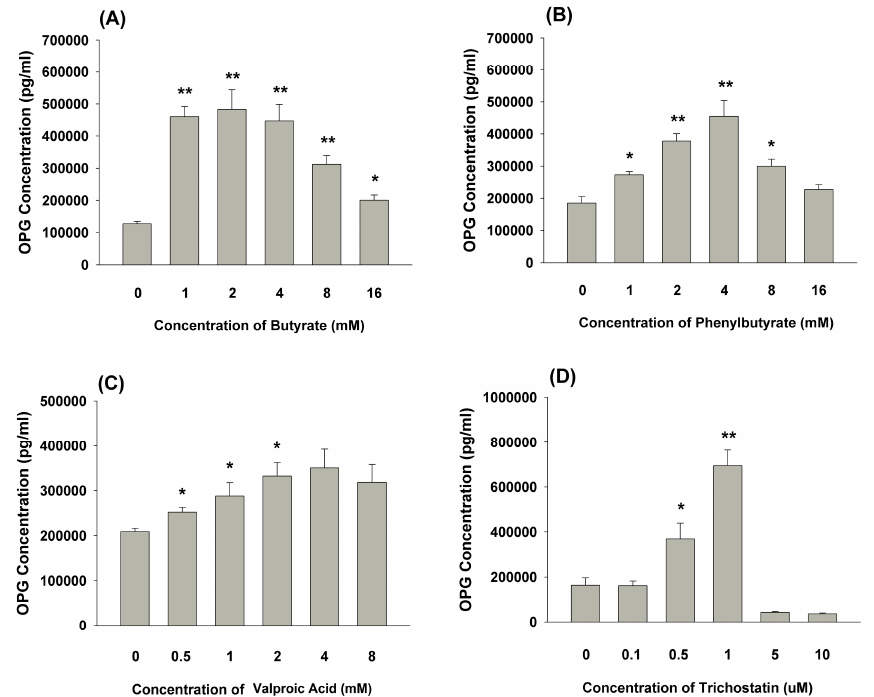
Figure 6. OPG secretion of MG-63 cells after three days of exposure to ( A ) butyrate, ( B ) phenylbutyrate, ( C ) valproic acid, ( D ) trichostatin for three days. The OPG level in the culture medium was determined by ELISA and expressed as mean ± SE (pg/mL). Statistically significant differences are denoted by * and ** ( p < 0.05 and p < 0.01) when compared with the control, respectively.